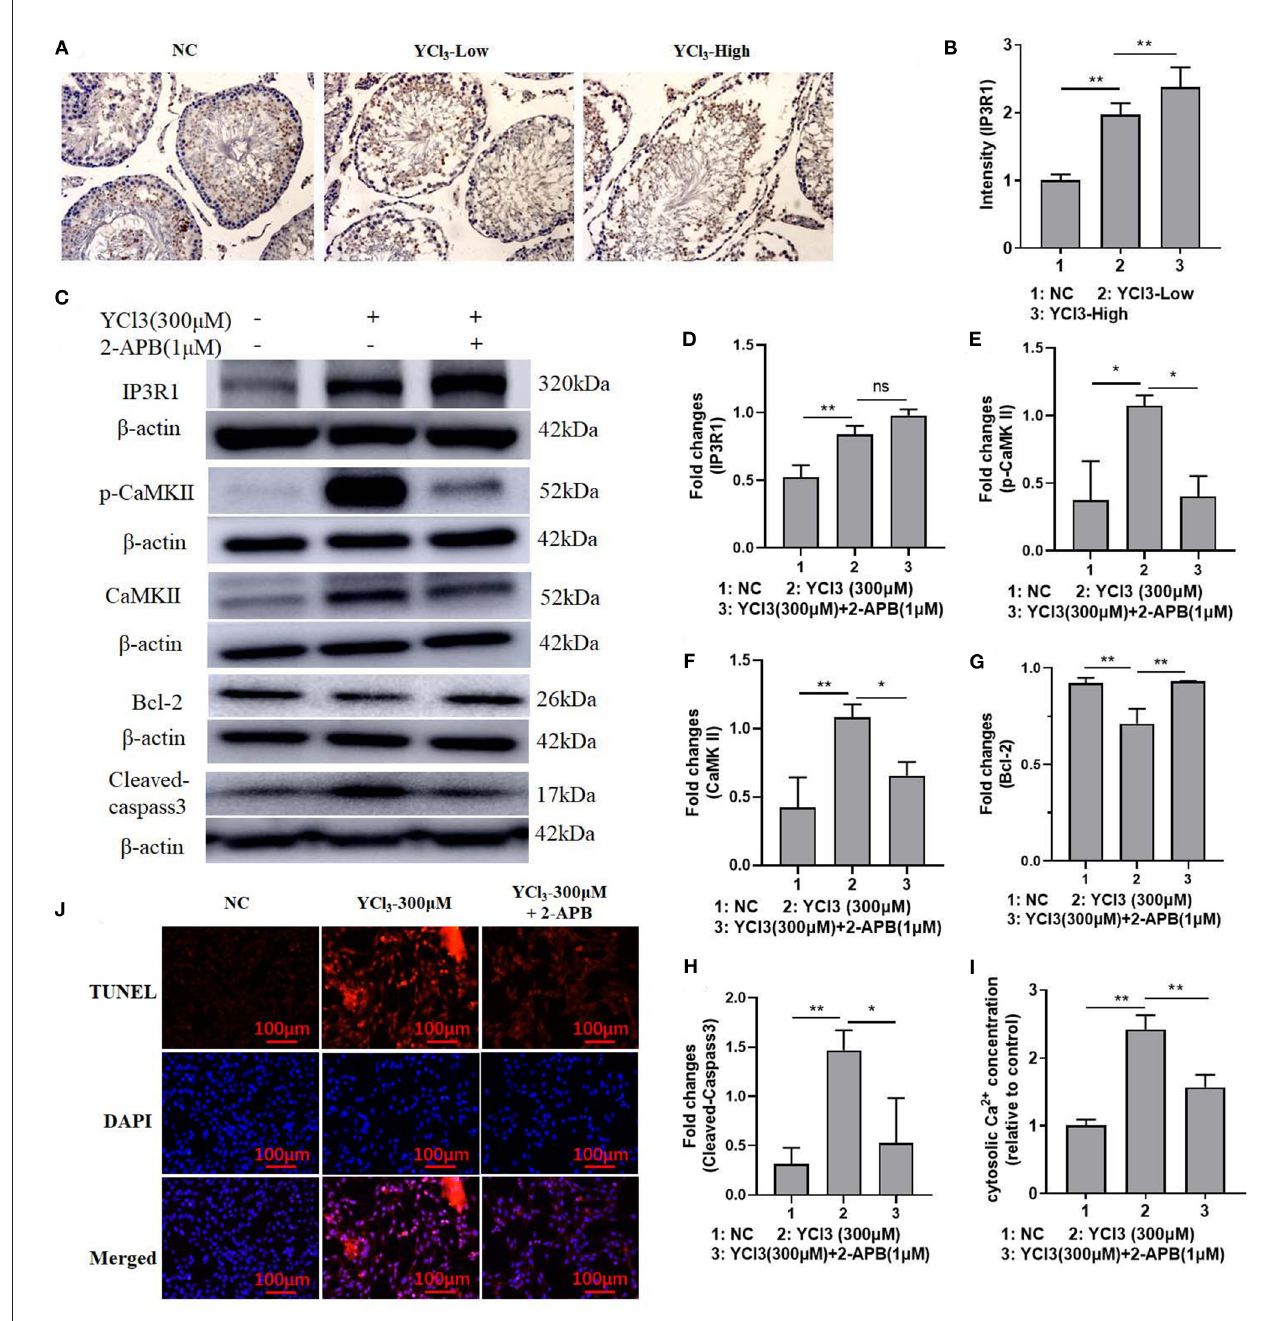
FIGURE3 The roles of IP3R1 in the induction of cell apoptosis by YCl 3 . The immunohistochemical study (magnification × 200) of IP3R1 in YCl 3 -treated rat testicular tissue was tested (A) , and it is quantified by intensity measurement (B) . Western blot assays were conducted for determination of IP3R1 (C, D) , p-CaMKII (C, E) , CaMKII (C, F) , Bcl-2 (C, G) , and cleaved-caspase-3 (C, H) protein expression. The cytosolic Ca 2 + concentration was detected by the kits (I) . TUNEL/DAPI assays were conducted for apoptosis detection (J) . * P < 0.05, ** P < 0.01. NC, negative control; YCl 3 -Low, 12 mmol/L YCl 3 ; YCl 3 -High, 24 mmol/L YCl 3